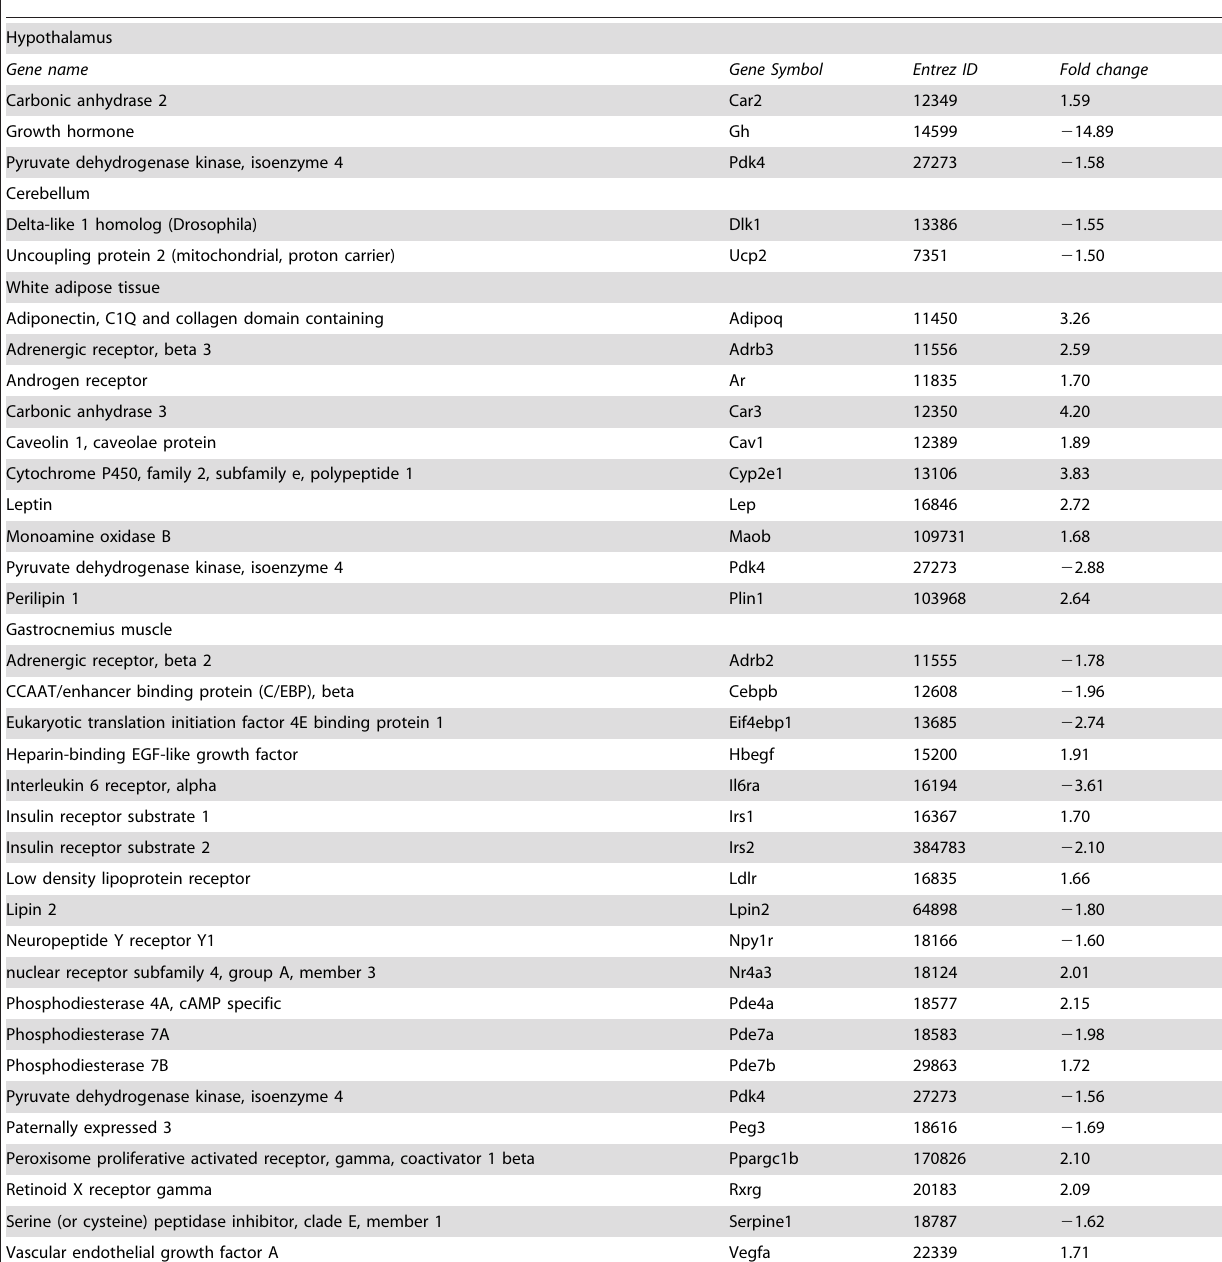
Table 3. Obesity-associated genes that show altered expression in FTO-4 mice.